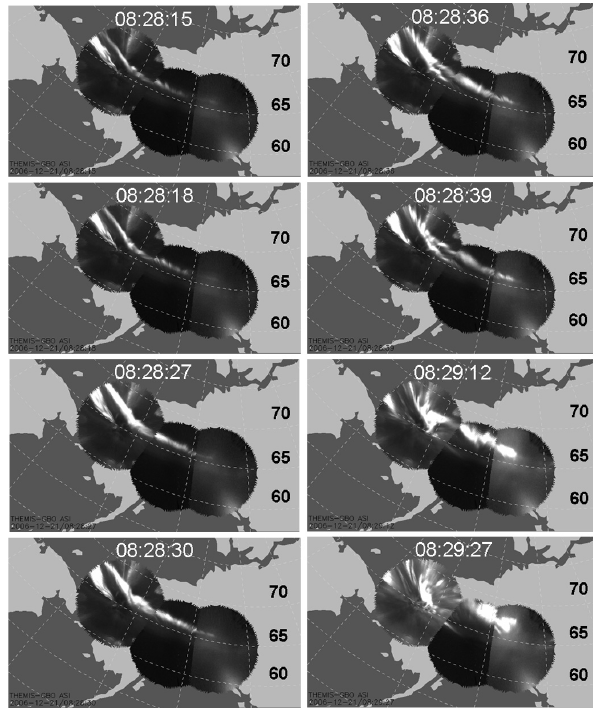
Fig. 2a. Evolution during 08:27:00–08:28:00UT of the 21 Decem- ber 2006 auroral substorm event observed by the THEMIS ground- based All-Sky-Imagers located at KIAN, GAKO, and WHIT.